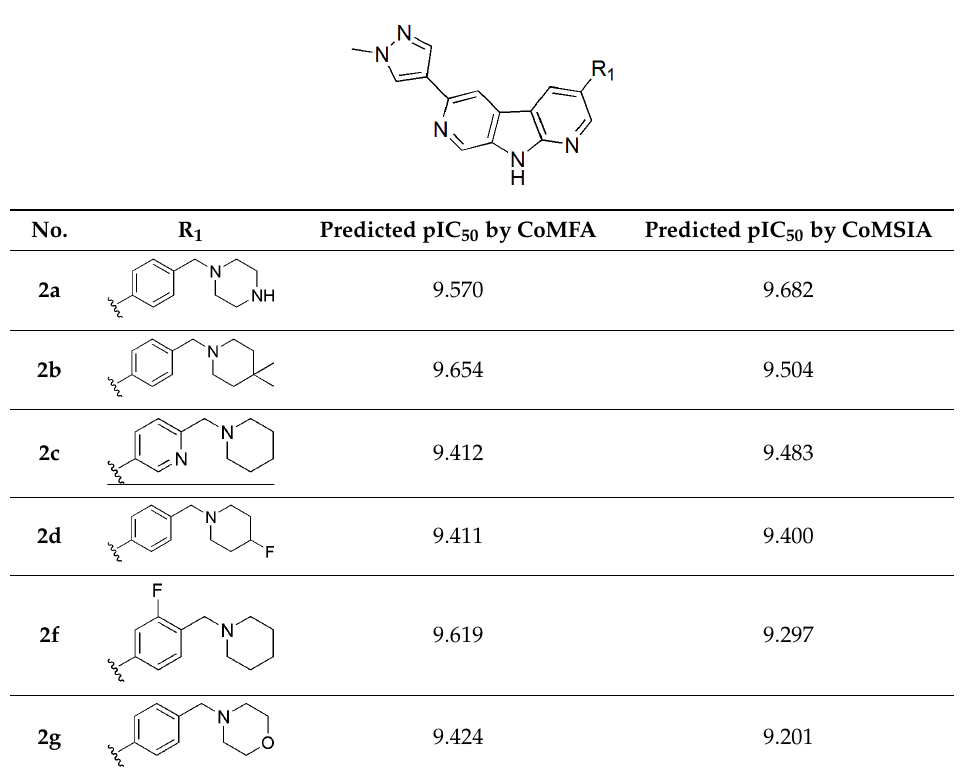
No. No. No. R 1 No. R 1 No. Table 3. Designed molecules and predicted inhibit activities values of Chk 1 through CoMFA and CoMSIA. No. No. R 1